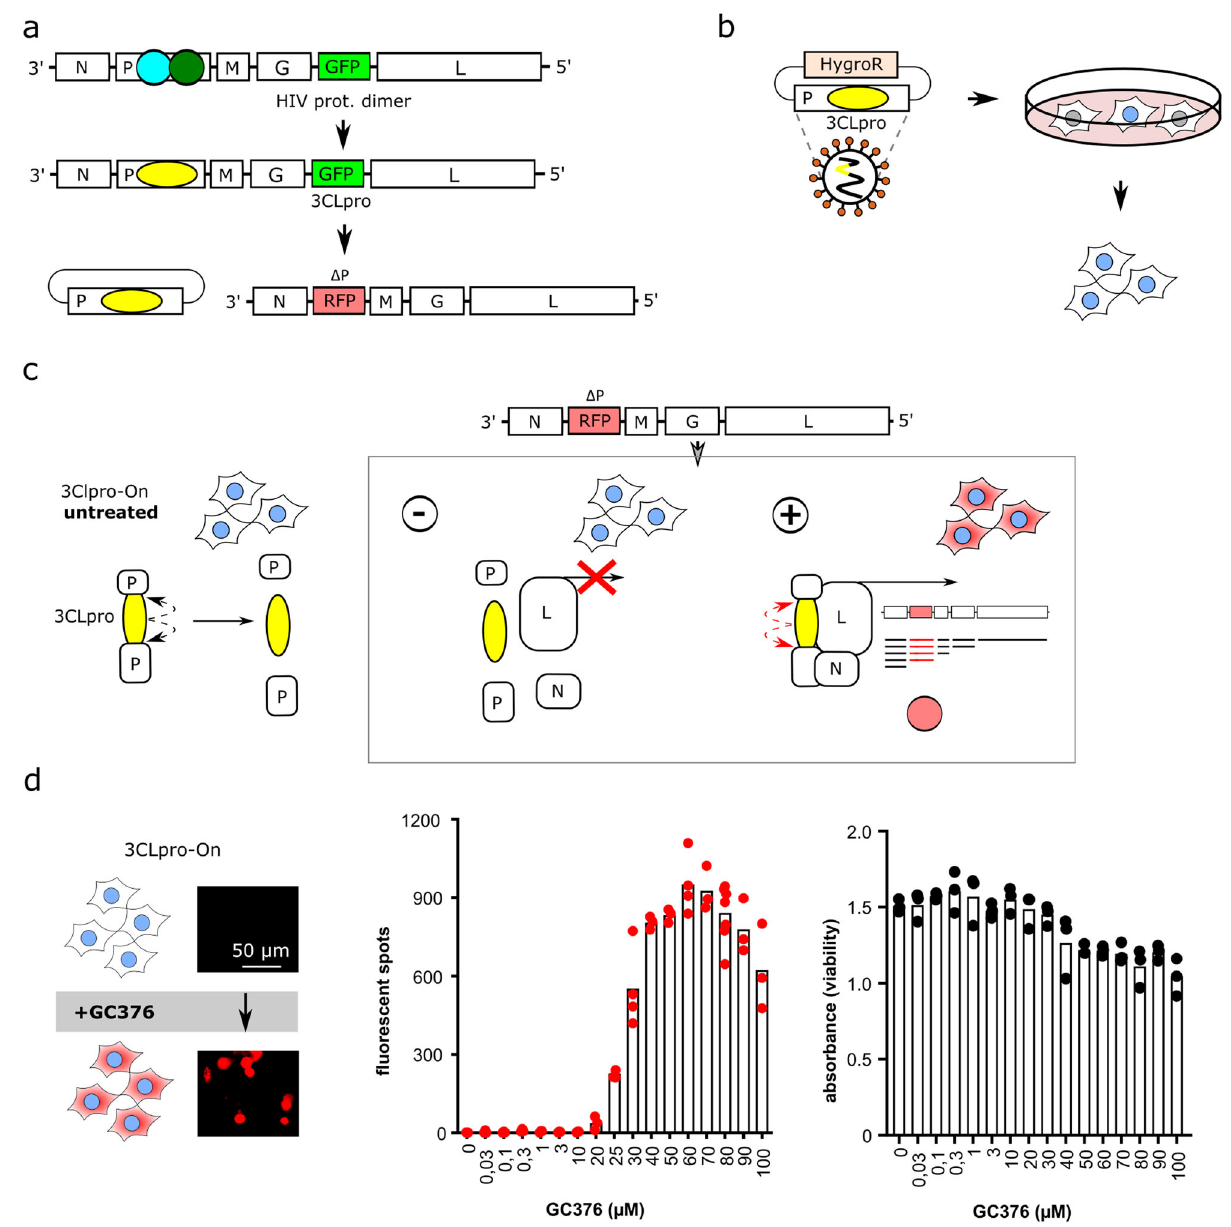
Fig. 2 Design principles of the inhibitor-on system for quantifying 3CLpro activity and chemical inhibition. a – c Schematics of the constructs leading to the current biosafety level 1 system consisting of VSV- Δ P-dsRed and Lenti-P:3CLpro with hygromycin-resistance cassette (HygroR). Co-expression of these two vectors in the same cells yields no virus replication due to VSV P protein auto-cleavage by 3CLpro. Treatment of these cells with a 3CLpro inhibitor restores P protein function and enables virus replication (inhibitor-on system). d GC376 causes a dose-responsive increase in dsRed signal. High compound concentrations cause a diminution of dsRed signal and a corresponding decrease in cell viability ( n = 3 biologically independent replicates per condition with individual data points shown and average values represented by histogram